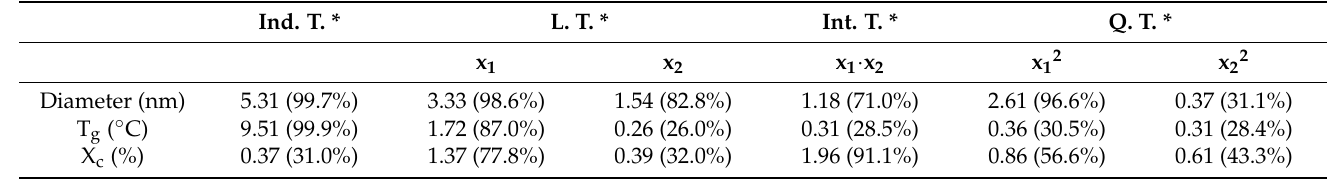
Table 4. t -value and confidence coefficient (%) for the different terms of each polynomial equations of the Box–Wilson model obtained for the studied properties.